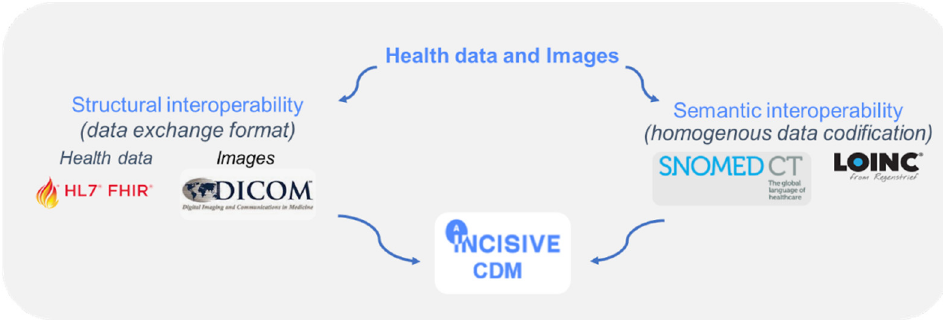
Figure 3. INCISIVE interoperability